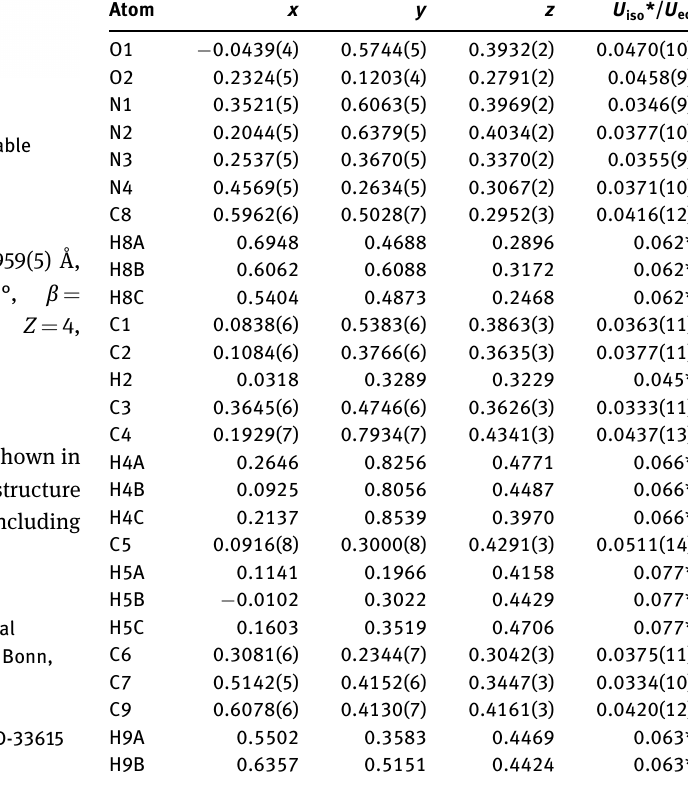
Table 2: Fractional atomic coordinates and isotropic or equivalent isotropic displacement parameters (Å 2